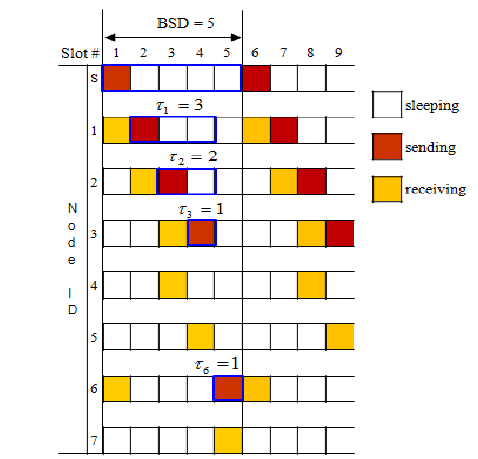
Figure 6. Example of BSD